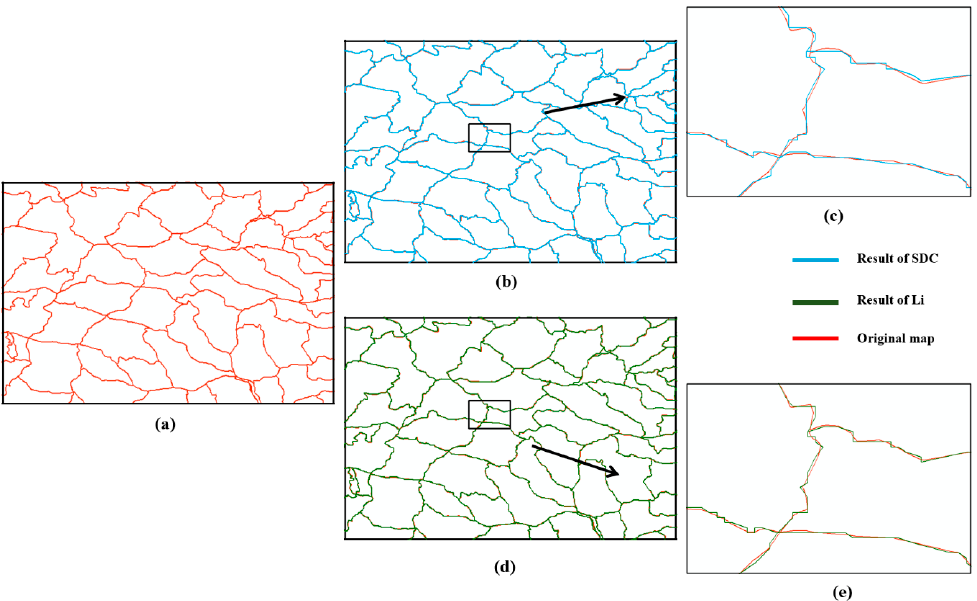
Figure 9. Overlaid results of different scales. ( a ) is the original map at a scale of 1:1,000,000; ( b ) is the compression map at the scale of 1:1,000,000 using the new algorithm and n is 15. ( c ) is the compression map zooming into a scale of 1:100,000 using the new algorithm; ( d ) is the compression map at the scale of 1:1,000,000 using Li’s method. ( e ) is the compression map zooming into a scale of 1:100,000 using Li’s method.